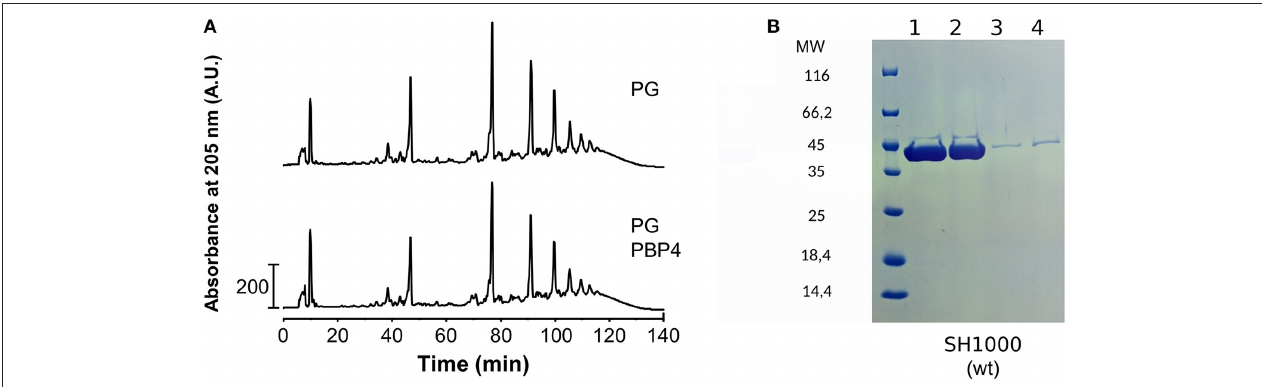
FIGURE 1 | PBP4 does not modify or interact with purified PG. (A) PG from S. aureus SH1000 was incubated with PBP4, followed by preparation and HPLC analysis of muropeptides. The muropeptide profile of the sample with PBP4 (bottom chromatogram) showed no significant difference to the control sample without PBP4 (top). This shows that PG is not a substrate for PBP4. (B) Interaction of PBP4 with peptidoglycan sacculi using pull-down experiments. Pull-down experiments were performed with purified PG from S. aureus strain SH1000. Samples were analyzed by SDS-PAGE stained by Coomassie Blue. PBP4 was present in the supernatant fractions (lanes 1 and 2) and largely absent in the PG fractions (lanes 3 and 4) showing that PBP4 does not interact with PG. Supplementary Figure S2 for HPLC and MS characterization and Supplementary Table 1 for resonance assignments on both peptides). Figure 2D shows the 1 H, 15 N-correlation spectrum of soluble PG fragments obtained by digestion with lysostaphin (see Supplementary Figure S1B for 1 H, 13